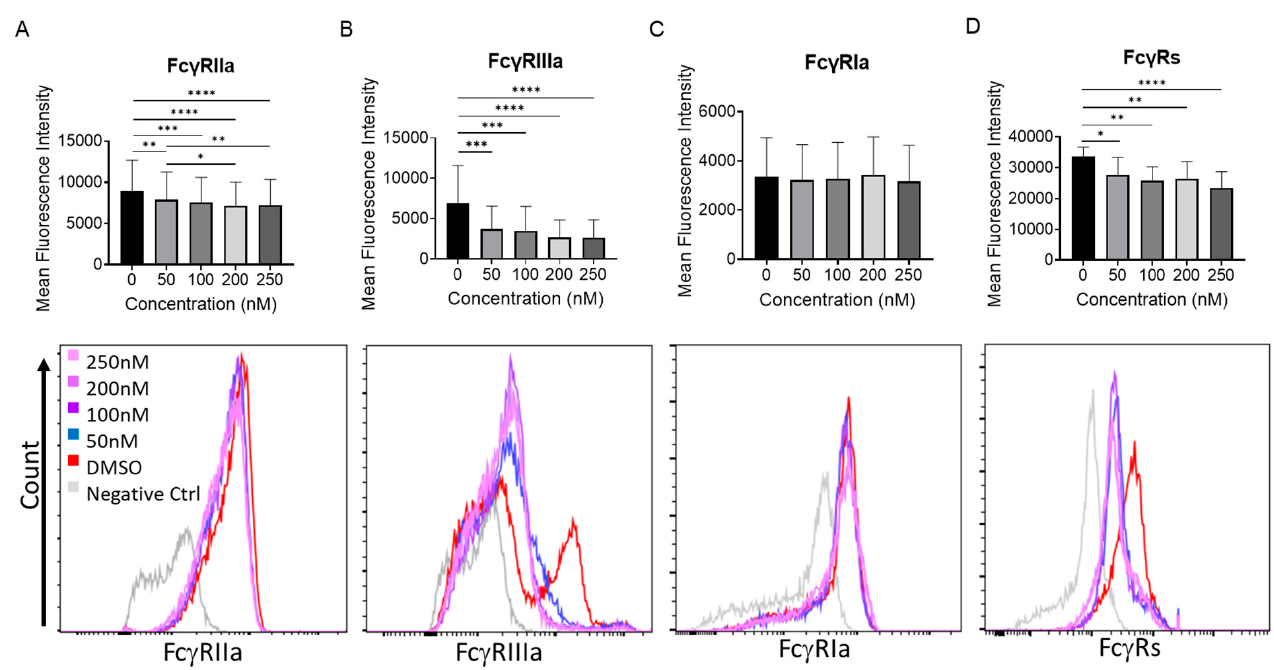
Figure 3. BET inhibition reduces Fc γ R surface expression in healthy human monocytes. Healthy- donor CD14 + monocytes were cultured for 24 h with PLX51107 (50, 100, 200, 250 nM) or with vehicle control (DMSO) for 24 h. Then surface expression of ( A ) Fc γ RIIa, ( B ) Fc γ RIIIa, ( C ) total Fc γ Rs and, and ( D ) Fc γ RIa was quantified by flow cytometry. Top panels show mean fluorescence intensities (n = 4), while bottom panels show representative histograms. * p ≤ 0.5, ** p ≤ 0.01, *** p ≤ 0.001, **** p ≤ 0.0001 respectively.